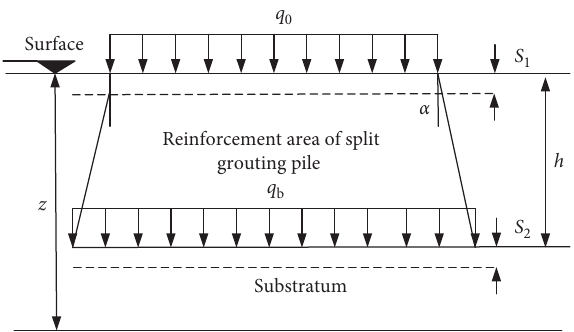
Figure 12: Schematic diagram of composite